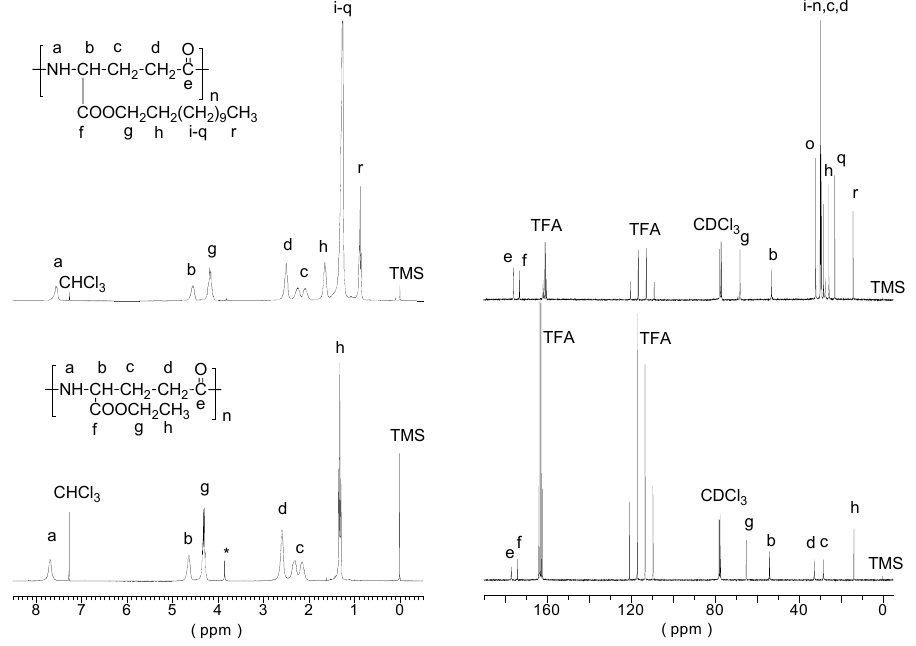
Figure 1. 1 H (Left) and 13 C (Right) Nuclear Magnetic Resonance (NMR) spectra of Poly( α -dodecyl γ -glutamate) (PAAG-12) (top) and PAAG-2 (bottom) with peak assignments. CDCl Figure 1. 1 H (left) and 13 C (right) Nuclear Magnetic Resonance (NMR) spectra of Poly( α -dodecyl γ - chloroform; TFA: trifluoroacetic acid; TMS: glutamate) (PAAG-12) (top) and PAAG-2 (bottom) with peak assignments. CDCl 3 : deuterated chloroform; TFA: trifluoroacetic acid; TMS: tetramethylsilane.